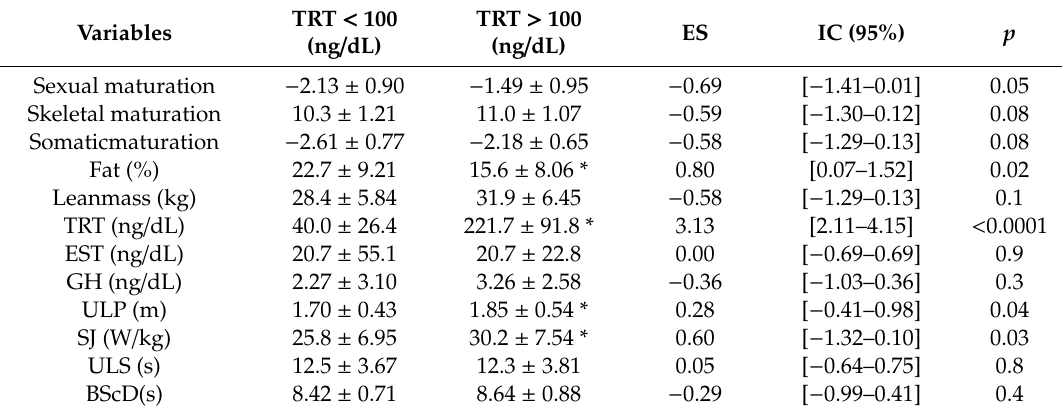
Table 6. Comparisons between subjects with testosterone levels < 100 (ng / dL) and > 100 (ng /